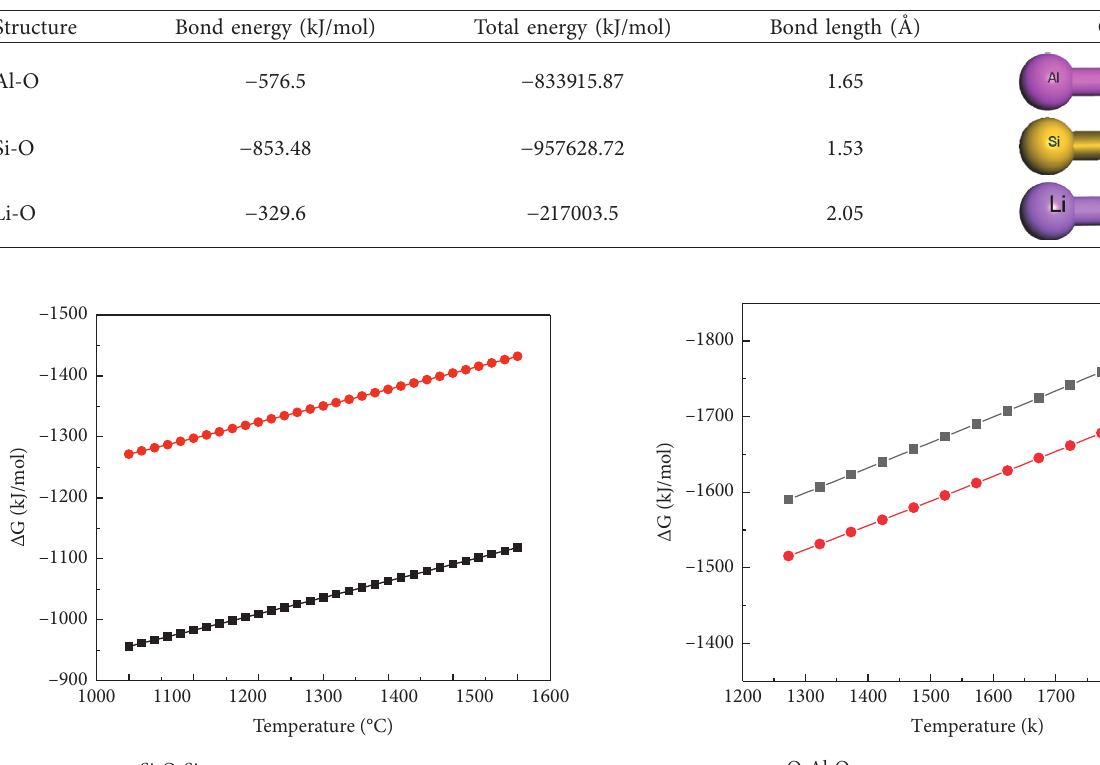
Table 1: The structure and energy of Al-O, Li-O, and Si-O.